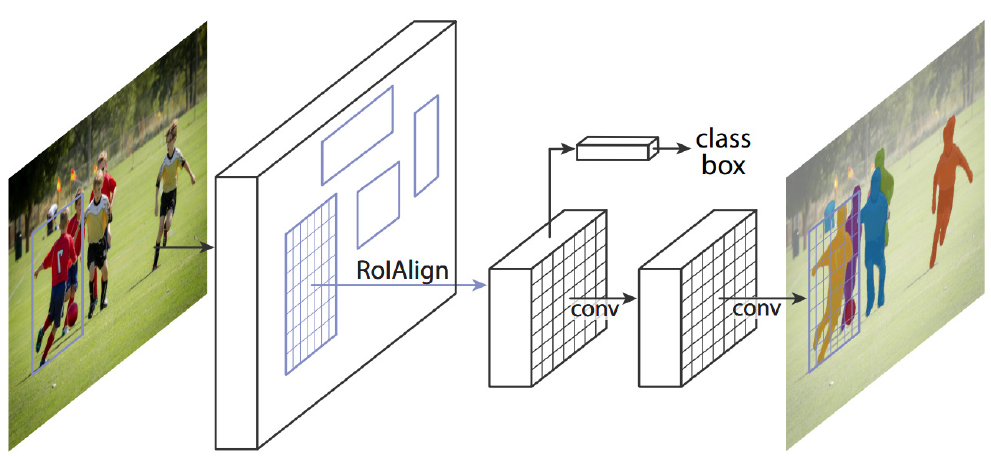
Figure 2. The Mask Regional Convolutional Neural Network (R-CNN) framework for instance segmentation [32].